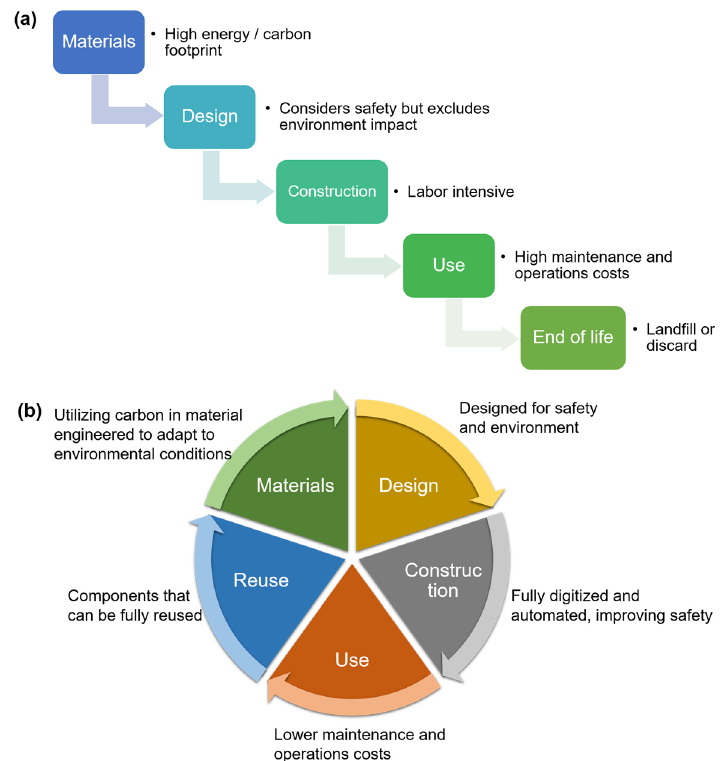
Figure 3 . (a) traditional infrastructure life cycle, and (b) sustainable alternative life cycle